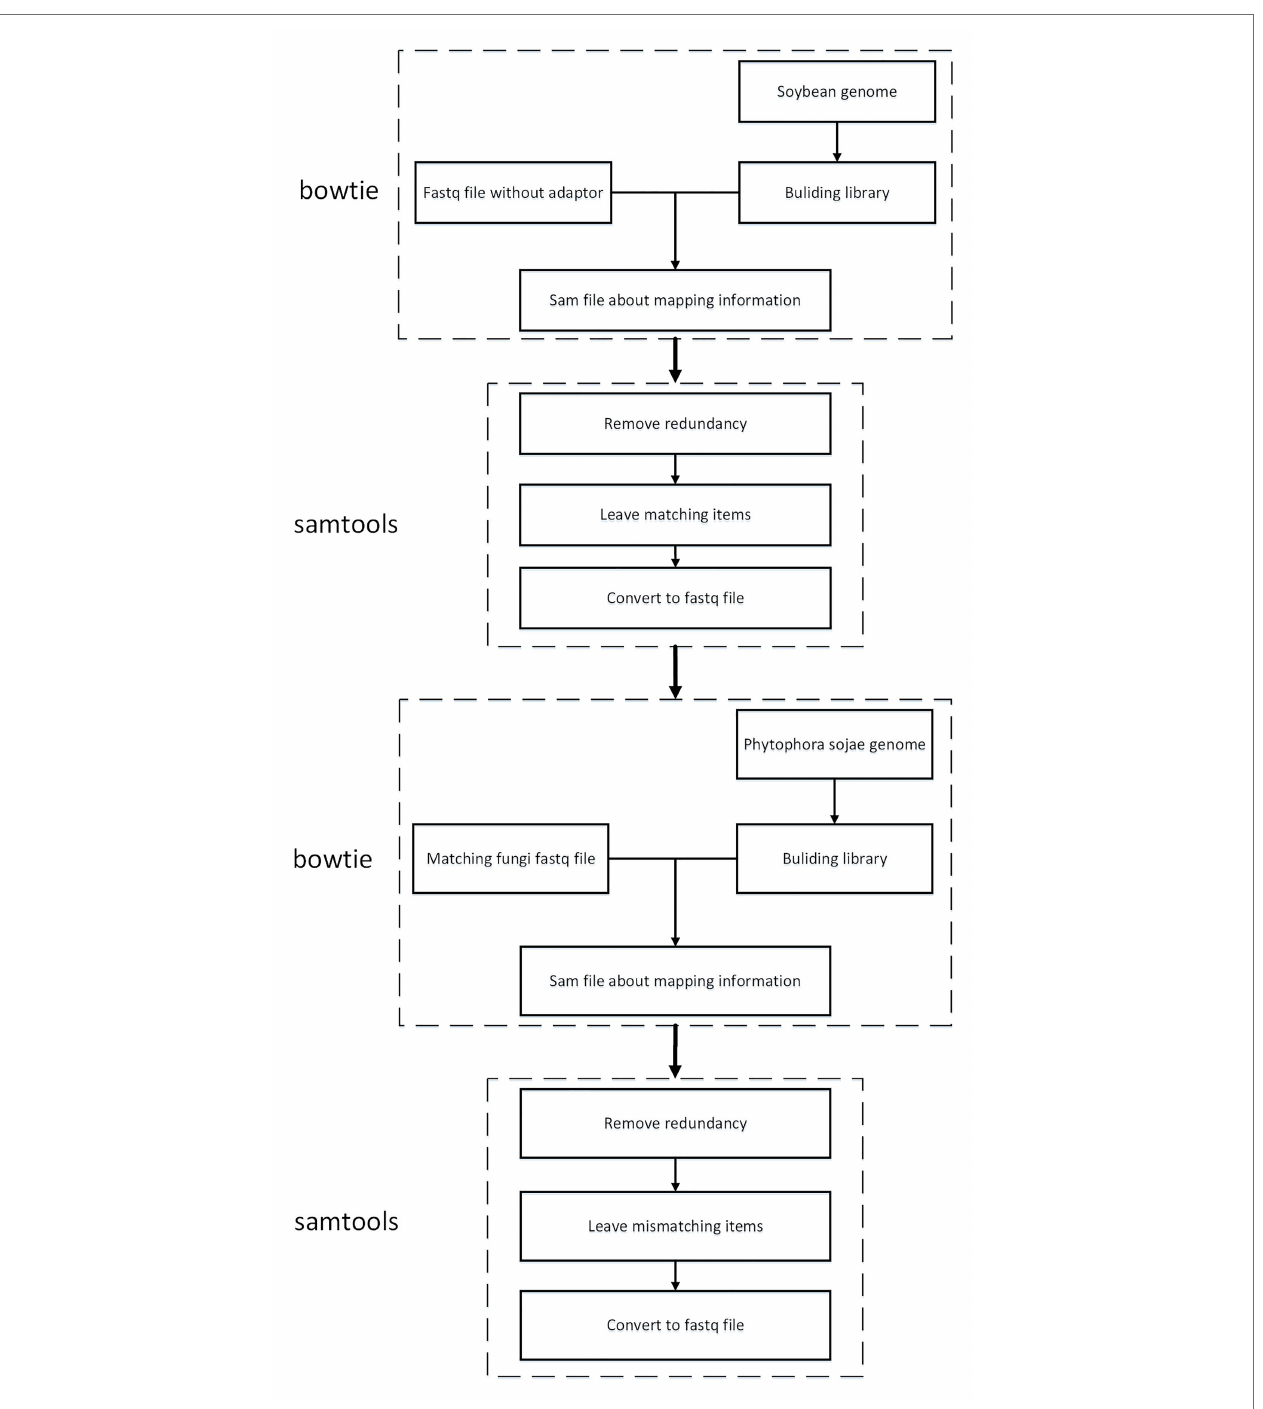
FIGURE 4 | Roadmap for data mapping to genome